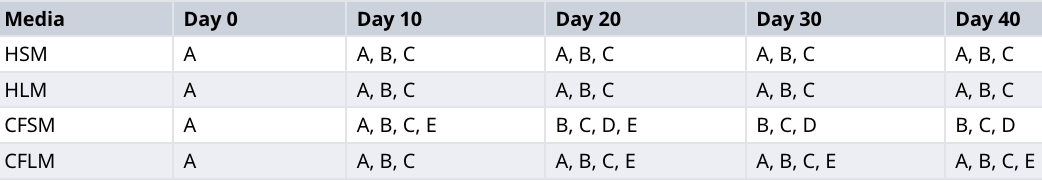
Table 14. First appearance and maintenance of morphotypes during long term culture in respiratory media.